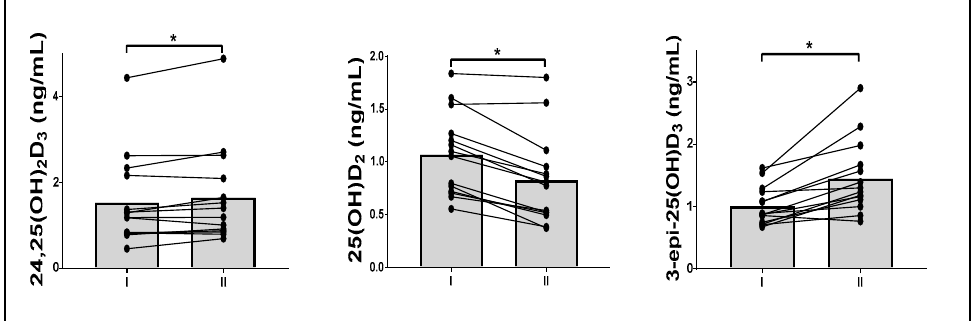
Figure 2. Starvation-induced changes in vitamin D metabolism. I, after overnight fasting; II, after 8 d of fasting. Shapes indicate the means (* p < 0.05, paired tests).